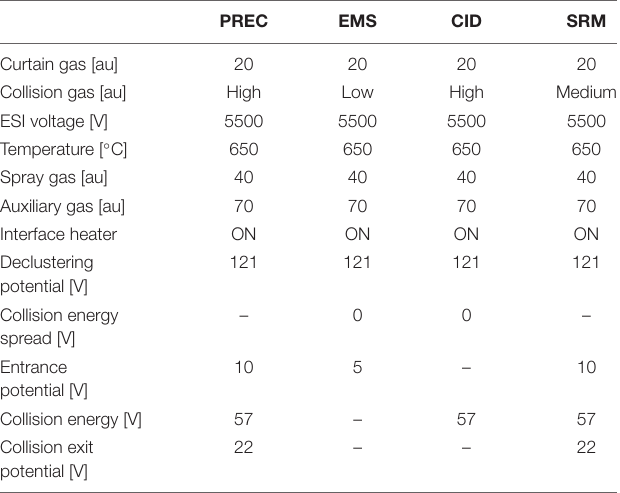
TABLE 1 | Mass spectrometric (ms) parameters used for